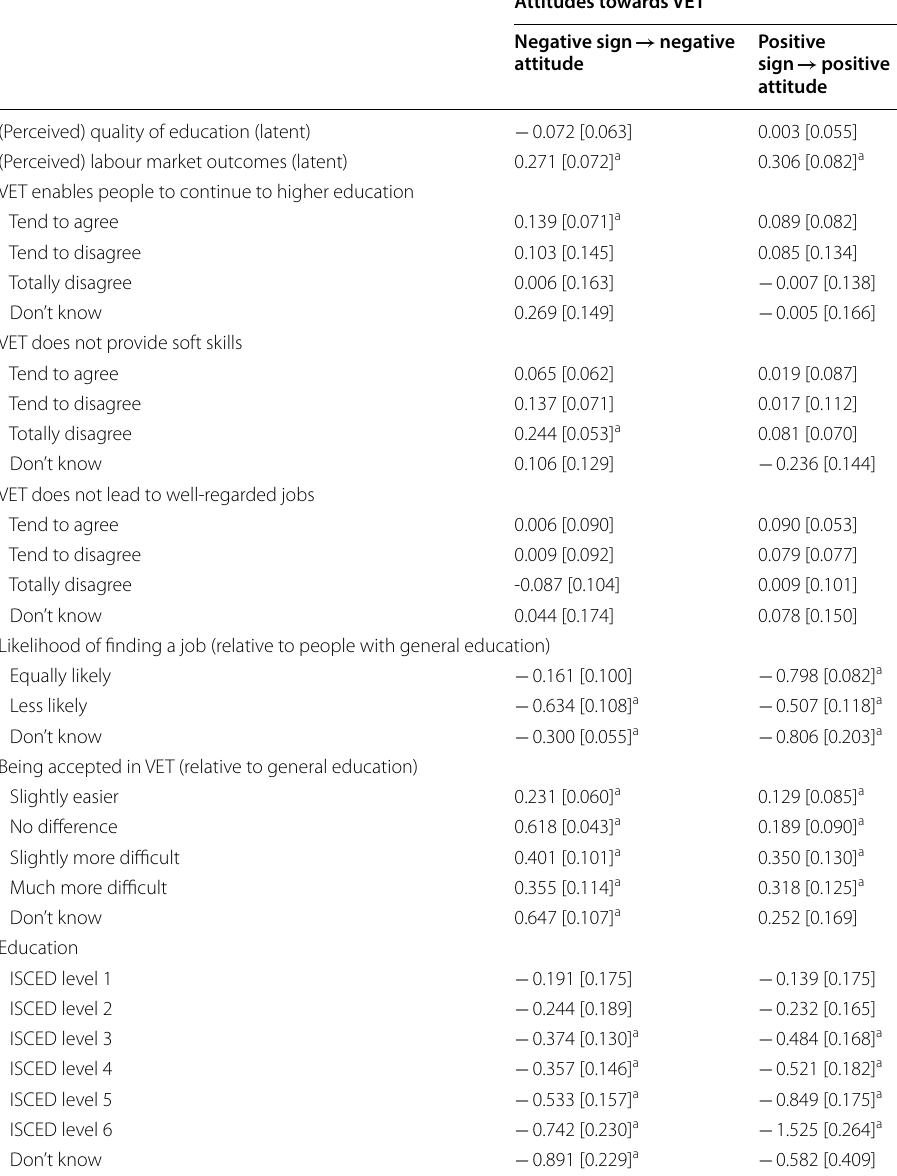
Table 6 Positive and negative attitudes towards VET. Negative signs in the column “Negative” increase the likelihood of a negative attitude; positive signs in the column “Positive” increase the likelihood of a positive attitude. Weighted data (clustered standard error in brackets)